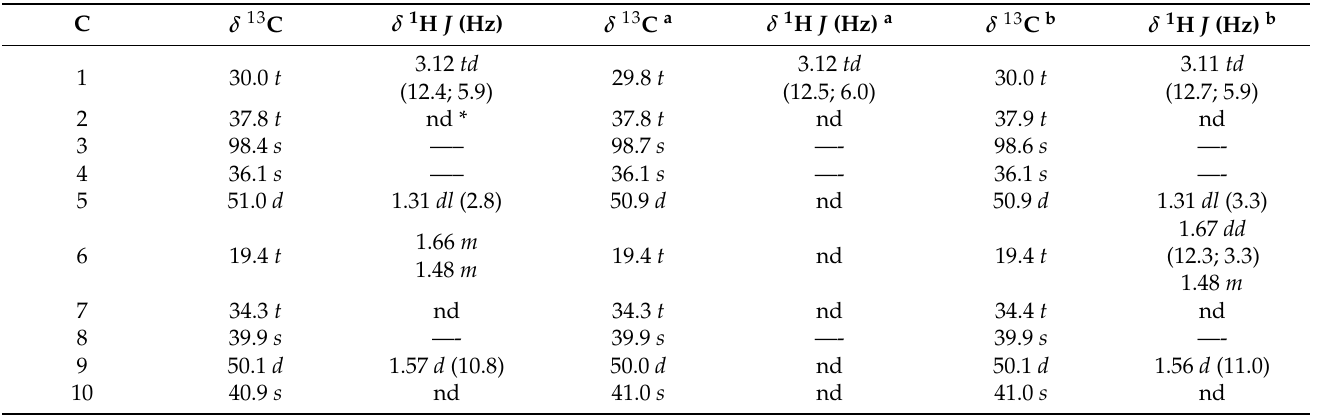
Table 2. NMR spectrometric data for cordialin A at 400 MHz for 1 H and 100 MHz for 13 C in CDCl 3 . Data from the literature are also